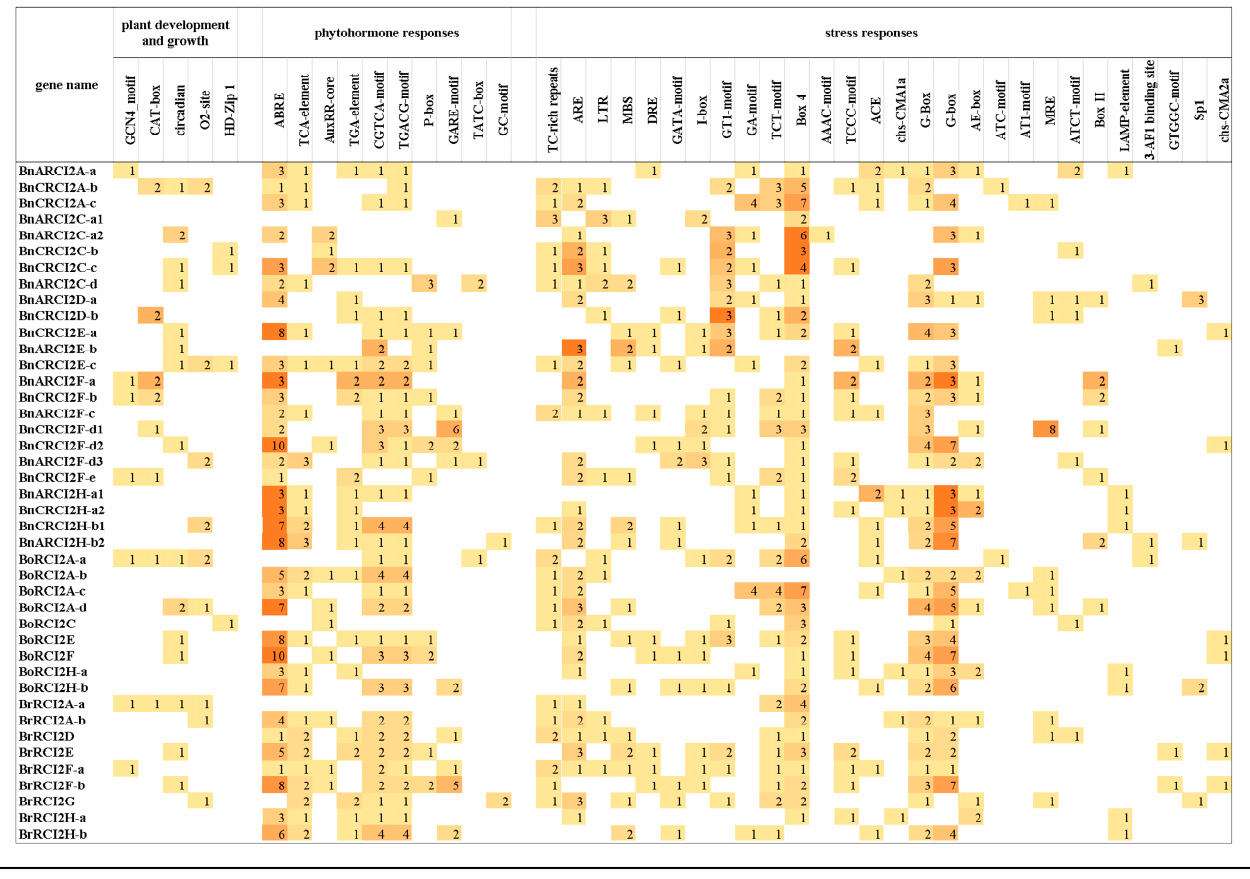
Figure 6. Cis -acting elements on promoters of all identified RCI2 genes. From the picture, there is a positive correlation between the value of the number and the shade of the color in each grid.